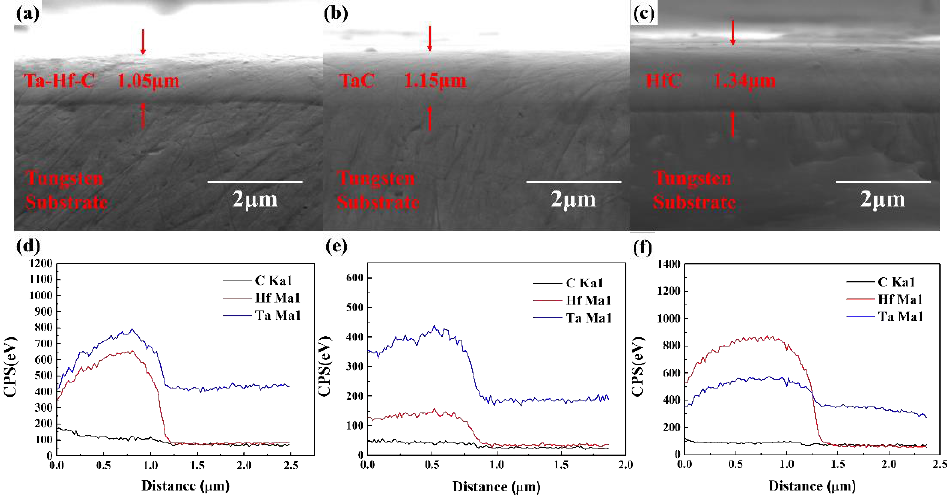
Figure 10. The SEM photographs of the Ta-Hf-C ( a ), TaC ( b ), and HfC ( c ) coating; The corresponding EDS line scanning results ( d – f ).